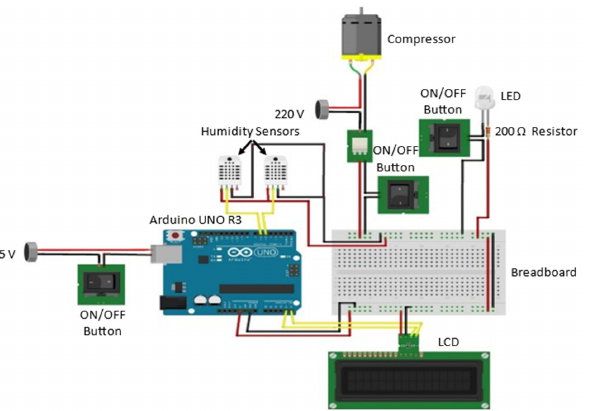
Figure 5. Schematic of electrical circuit of the Cascade System for Biomineralization in Cement. Besides the electrical and electronic components, a circuit ‐ breaker box and wire organizer spirals were used to house the circuit and offer protection and stability to the parts and instruments. The supervisory control was connected to a 220 V supply with a current of 10 A. A 5 V source converted the 220 V to the 5 V of supply for the Arduino. A 220 V link was connected directly to the open relay module to be activated only with the supervisory control command. The total power of the CSBC was also calculated as the sum of powers of the stove, the LED, the two humidity sensors and the Arduino UNO R3 microcontroller. 3. Results 3.1. Determination of Calcite Solubility Curve Based on data described by Visscher and Vanderdeelen [16], 60 pairs of data were collected at temperatures in the selected range (5–35 °C), and the calcite solubility curve was plotted (Figure S1). The first point to discuss regards the reliability of the data source. The other point deals with the logarithmic solubility curve with a determination coefficient (R 2 ) of 0.954, indicating that the 60 pairs of data were in good agreement with the curve. 3.2. Cascade System for Biomineralization in Cement (CSBC) As mentioned earlier, the CSBC was constructed in the following two steps: (I) process engineering and (II) instrument, electrical and programming step. 3.2.1. Process Engineering Step Figure 6 shows the CSBC with its supervisory control, stove, humidity chamber and humidity sensors. The equipment had an aeration system from the supervisory control to the stove and from the stove to the humidity chamber. Air was taken from the environment and returned to the same environment.